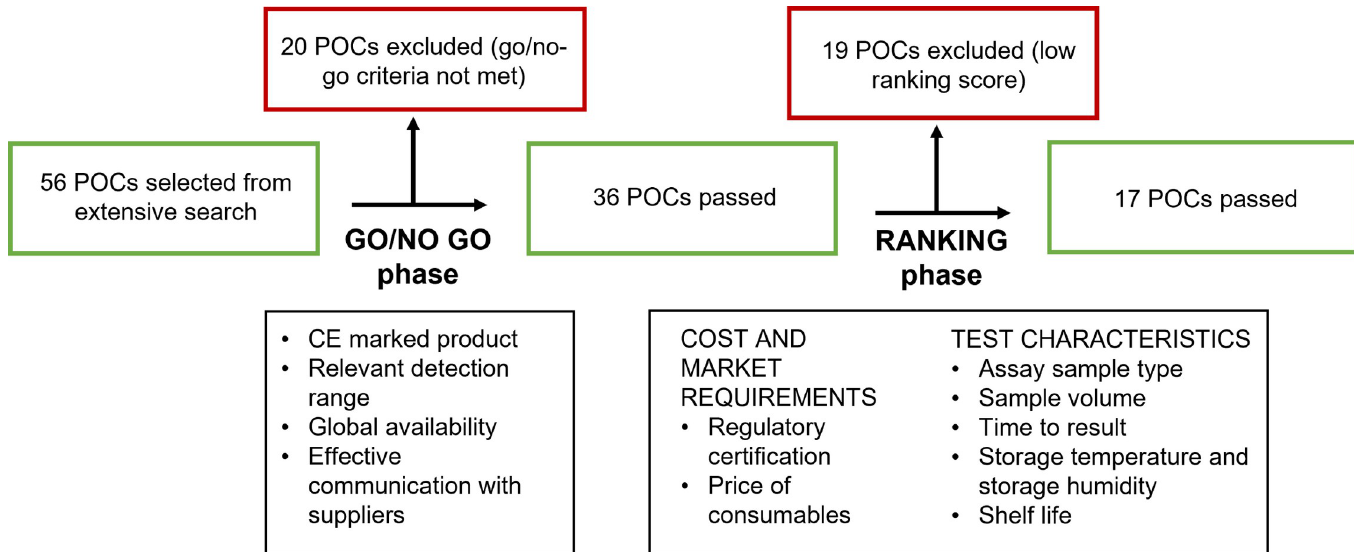
Fig 1. Flowchart for tests selection. Go/no go criteria included both objective and subjective criteria: Whether the test was CE-marked, relevant detection range (from 10 to 100 mg/L CRP for a quantitative test, and one cut-off value of � 20 mg/L for qualitative and semi-quantitative tests), worldwide distribution, and responsiveness of the manufacturer. Ranking criteria included: Additional regulatory certification (higher score for US Food and Drug Administration-approved products); cost of consumables (lower score for test price > 10 USD, higher score for test price < 1 USD); assay sample type (lower score for tests requiring serum samples only, higher score for tests that can be used with capillary whole blood, venous blood, or plasma); sample volume (lower score for tests requiring a volume of > 50 μ L, higher score for tests requiring a volume of < 10 μ L); time to result (lower score for tests requiring > 20 min, higher score for tests requiring < 5 min); storage temperature (lower score for tests requiring < 4˚C, higher score for tests stable up to 40˚C); shelf-life (lower score for tests stable for < 12 months, higher score for tests stable for > 24 months).